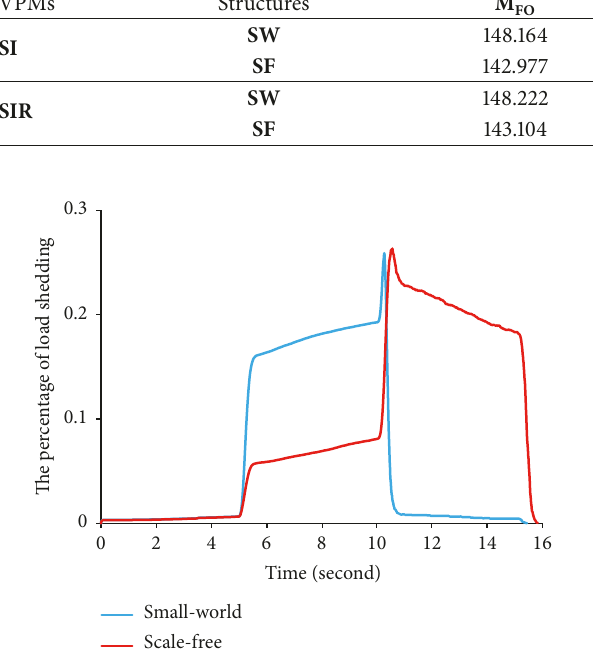
Figure 4: Load shedding of IEEE 118-bus system over time based on SI